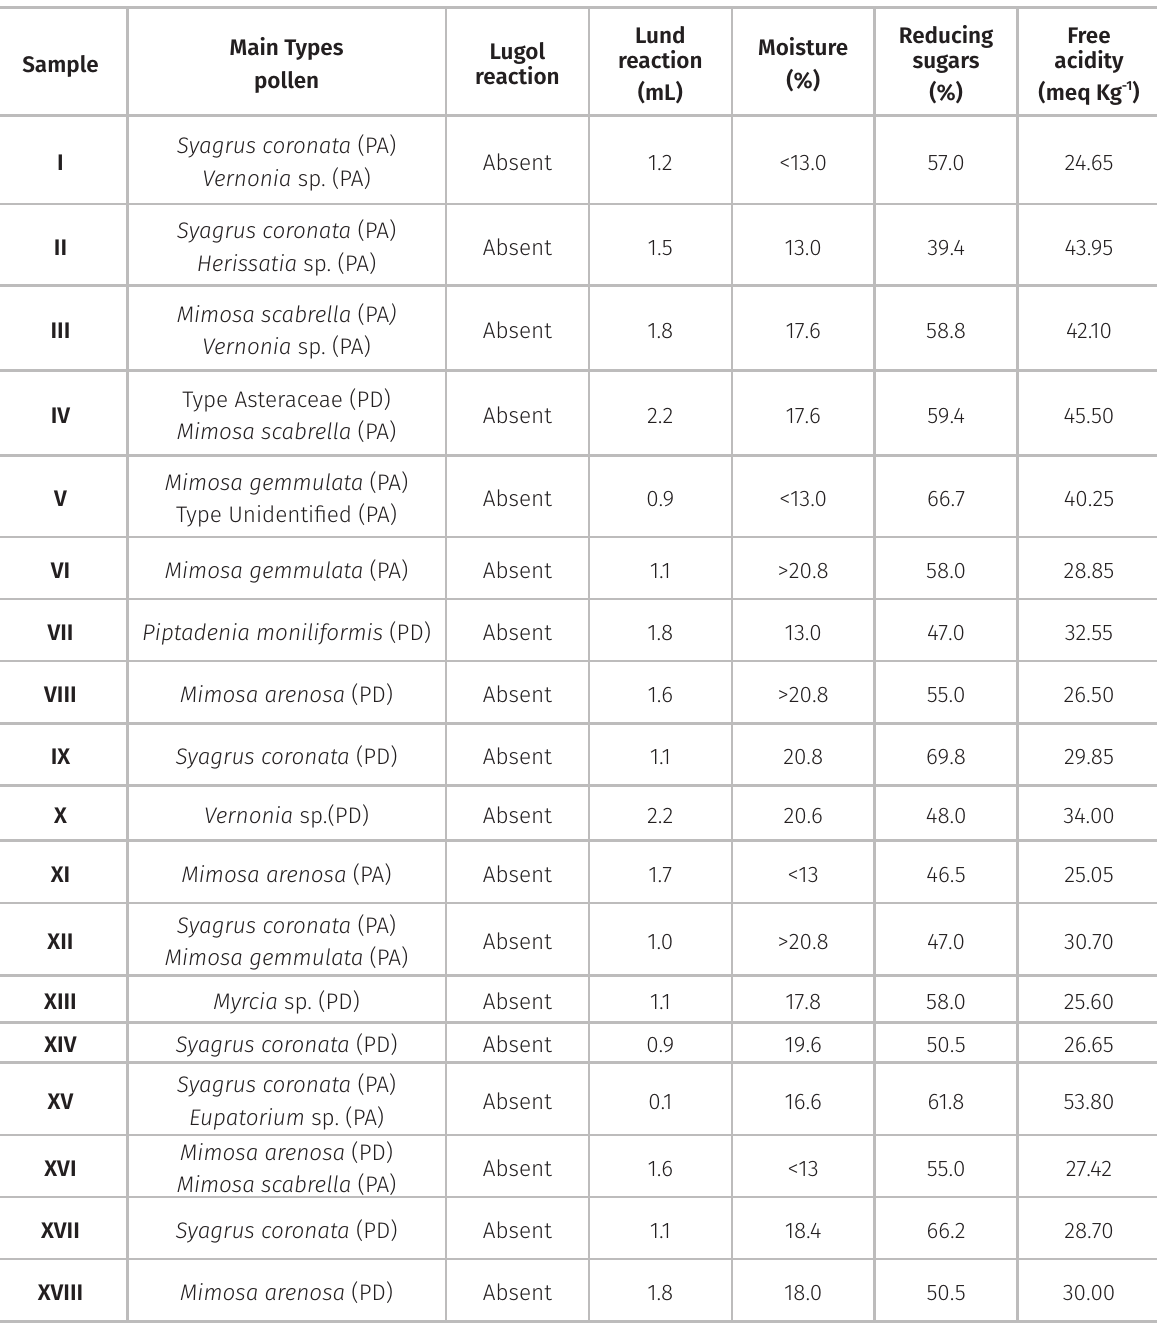
Table IV. Palynological and pysicochemical analysis of honey samples marketed in municipalities in the region Paraguaçu River,